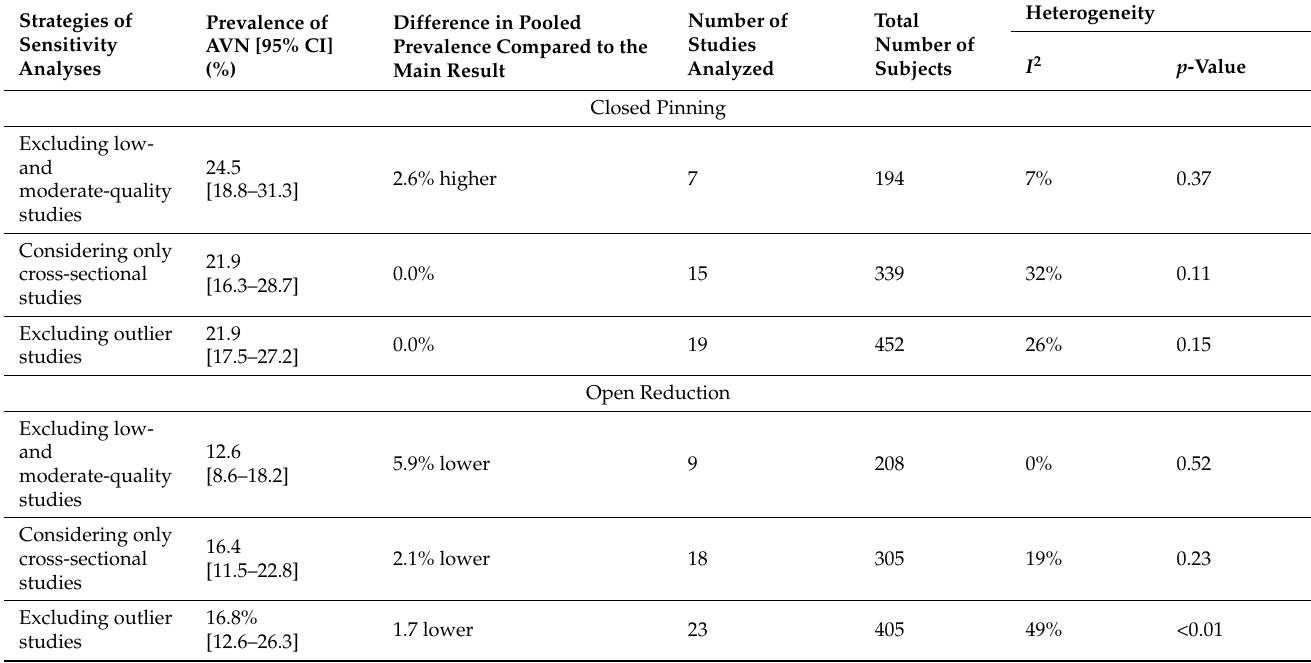
Table 6. Sensitivity analyses.